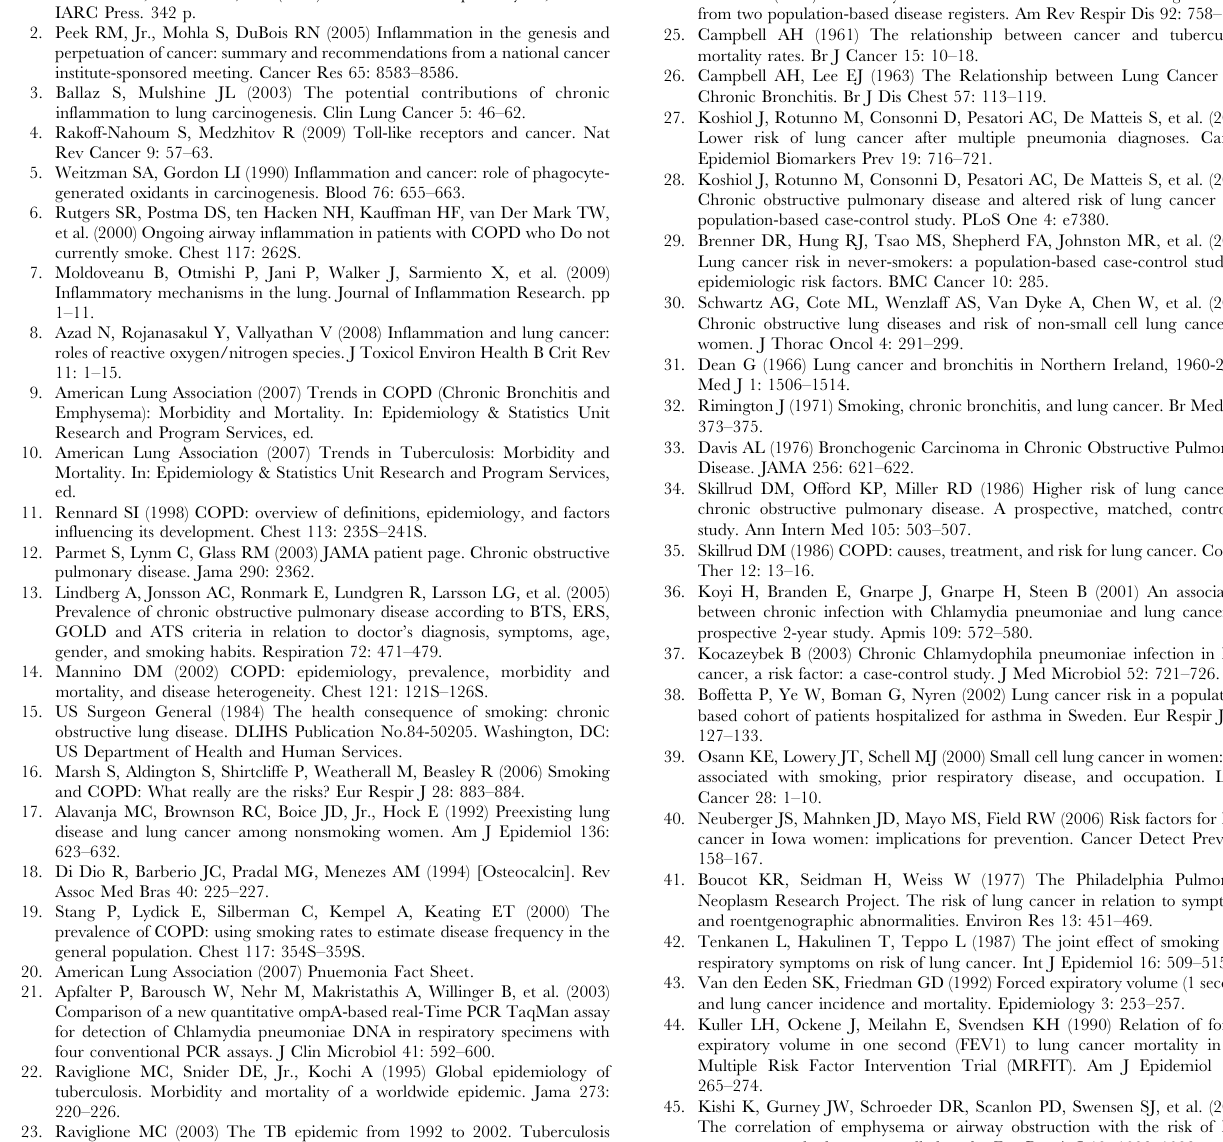
Figure S9 Funnel plot of the effects of chronic obstruc- tive pulmonary disease across studies.